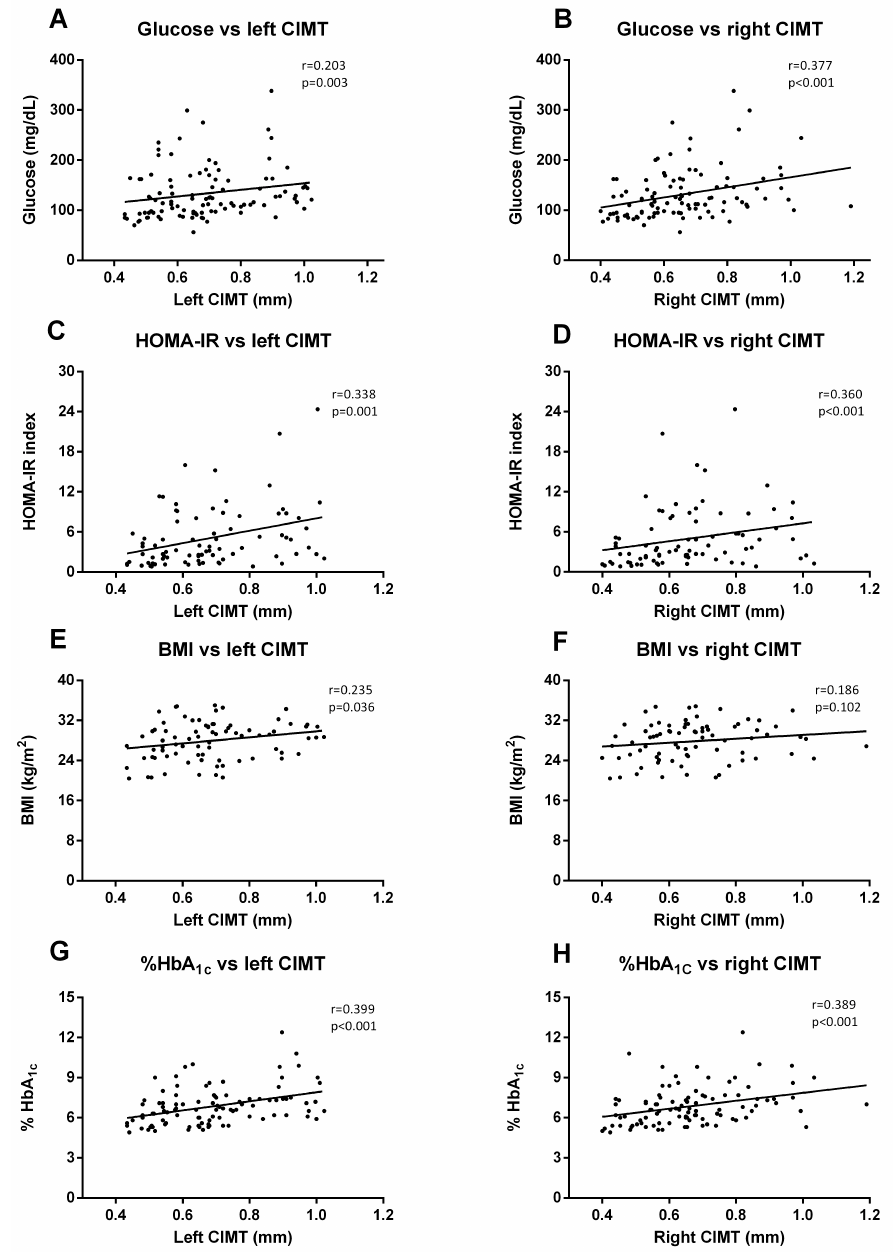
Figure 5. Correlation graphs of biochemical and anthropometrical parameters vs. CIMT measures. Graphs show correlation between glucose levels and left ( A ) and right CIMT ( B ); HOMA index and left ( C ) and right CIMT ( D ); BMI and left ( E ) and right CIMT ( F ); and HbA 1c and left ( G ) and right ( H ) CIMT. Spearman correlation analysis was performed.